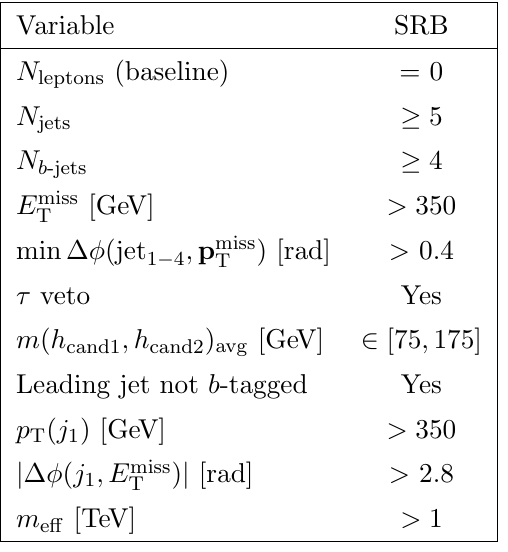
Table 2. De(cid:12)nitions for SRB, targeting the compressed region of the (cid:1) m (~ (cid:31) 0 scenario. The jets and b -jets are ordered by p T